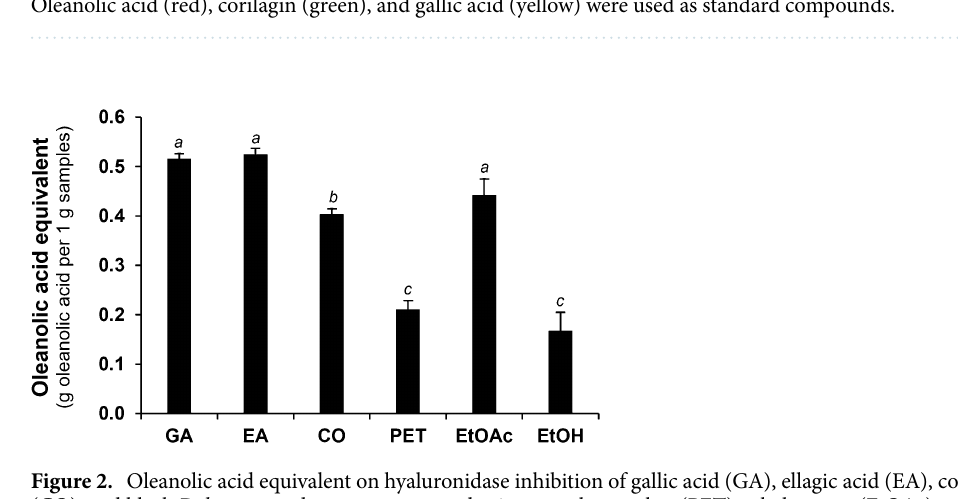
Figure 1. Dose–response curve of black D. longan seed extracts, extracted using petroleum ether (blue), ethyl acetate (violet), and 95% v / v ethanol (gray), indicating matrix metalloproteinase-1 (MMP-1)-inhibitory activity. Oleanolic acid (red), corilagin (green), and gallic acid (yellow) were used as standard compounds.